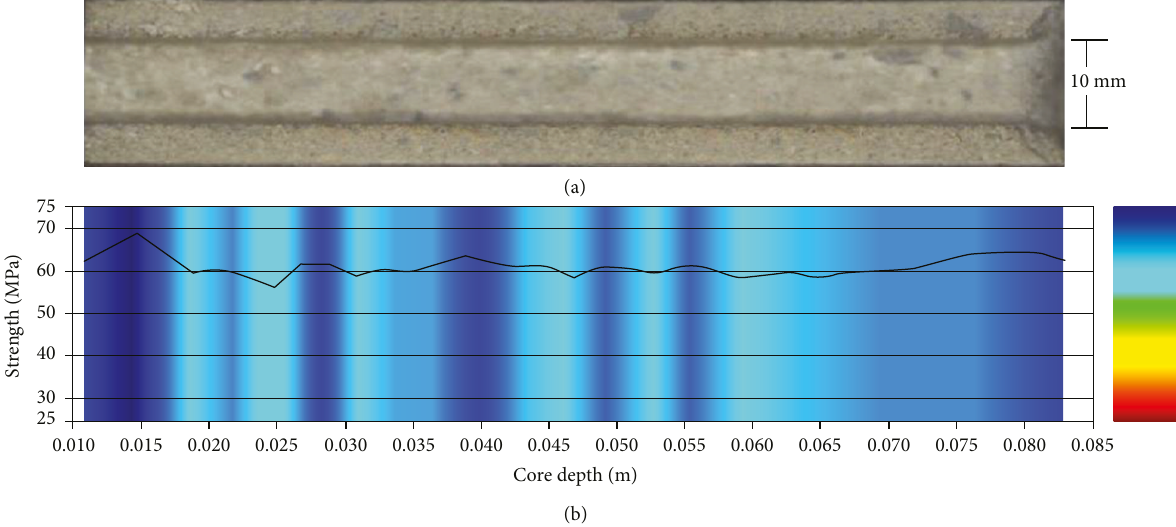
Figure 3: Continuous strength pro fi le of the cement sample obtained from the scratch